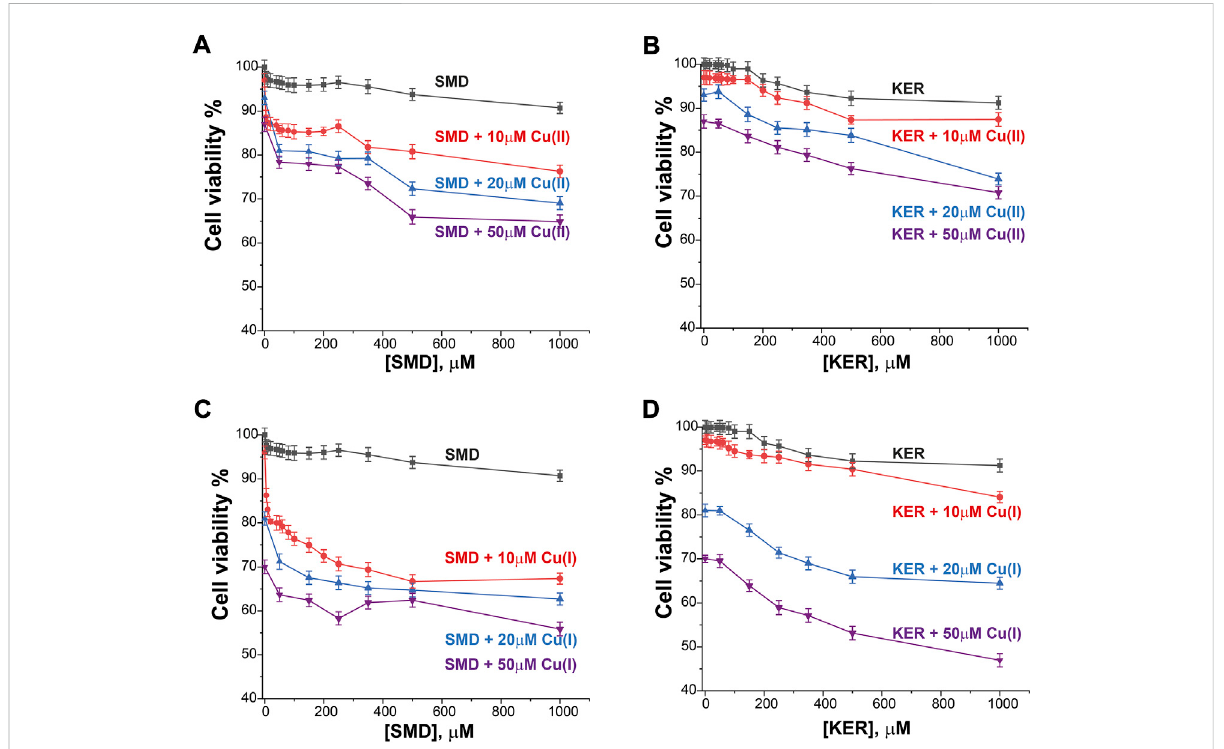
FIGURE 4 HEK293cellviability inthepresenceofSMDpeptideatvaryingCu(II)andCu(I)concentrations in (A) and (C) ,respectively, andinthepresenceof KER peptide at varying Cu(II) and Cu(I) concentrations (B) and (D) , respectively. At [peptide] = 0, cell viability in the presence of [Cu(II)/Cu(I)] is given. Error bars were calculated based on three independent